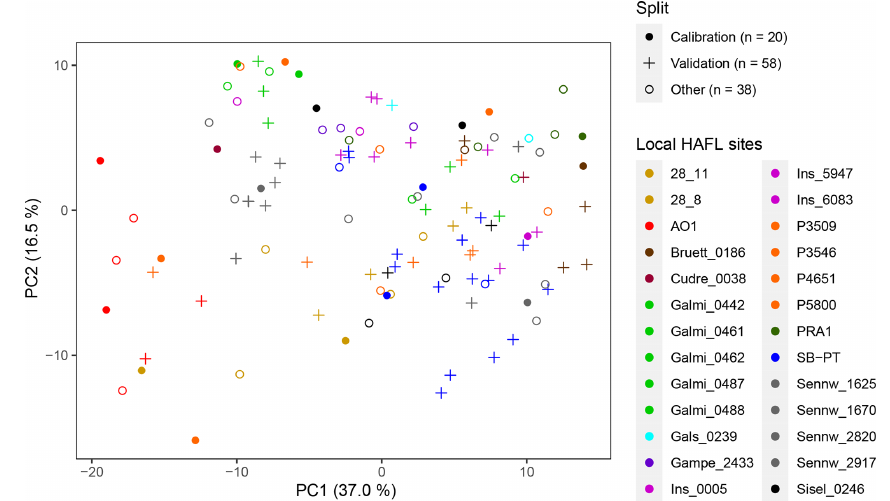
Figure C1. PC1 vs. PC2, computed via scaled and centered PCA, of the preprocessed local HAFL soil spectra ( n = 116) colored by location, in contrast to Fig. 4. The axes labels show the relative amount of variance explained (percent) in parentheses. In this example, n = 20 representative samples were selected for calibrating a local model using the KS algorithm, and the rest of the data were used for validation ( n =